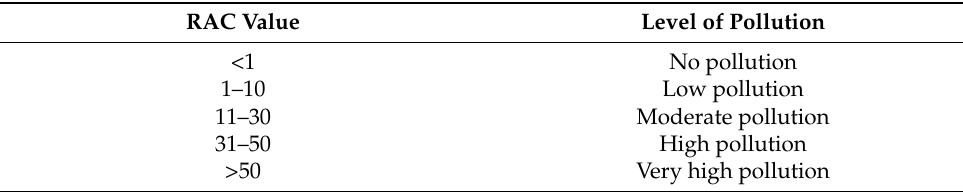
Table 5. Classification of RAC [45].